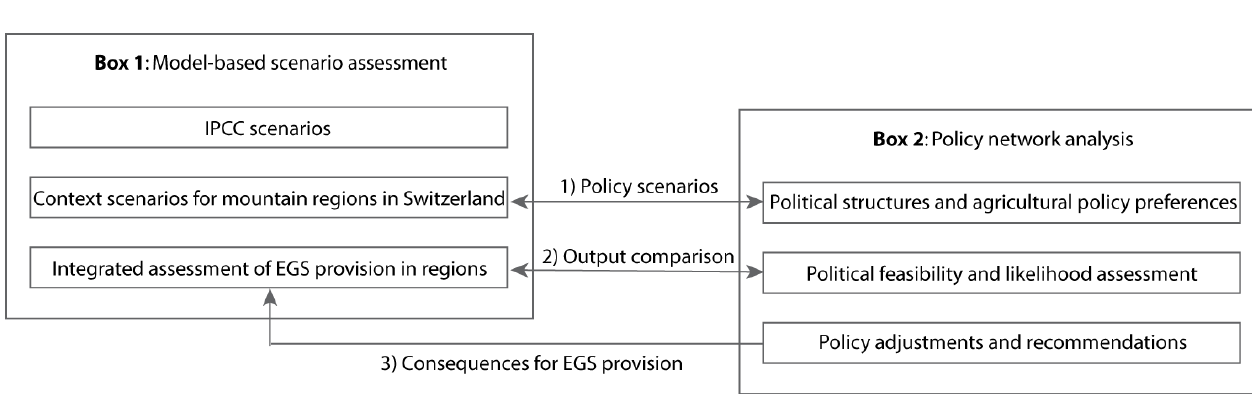
Fig. 1 . Conceptual